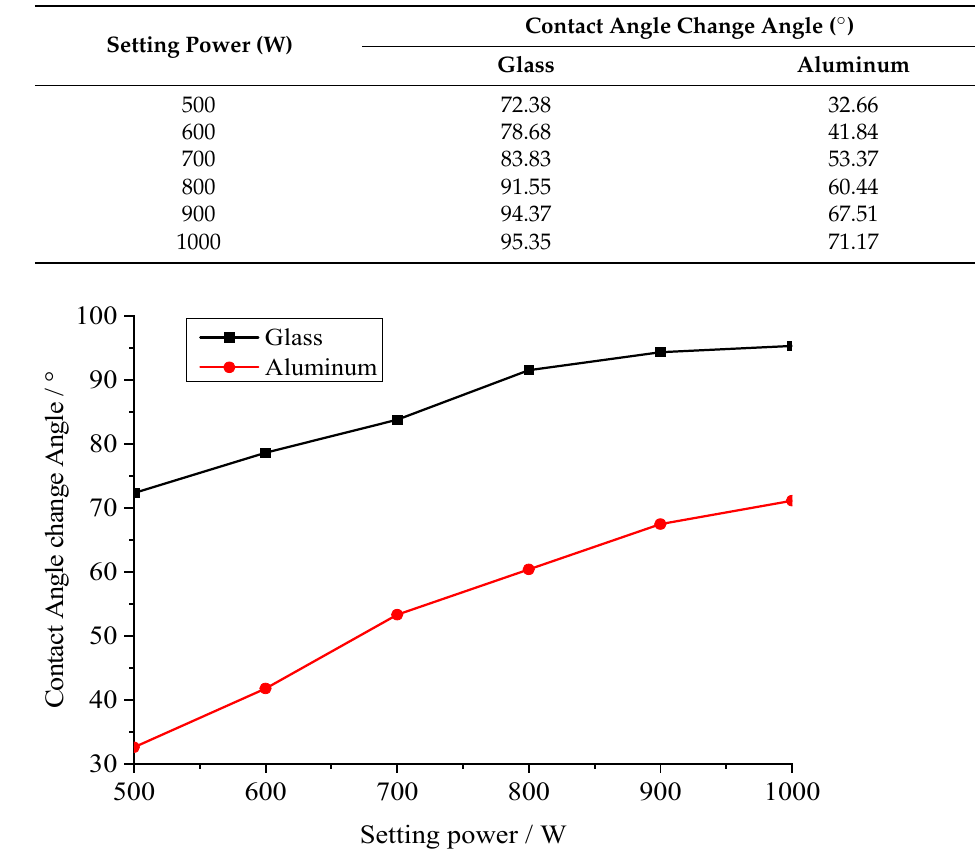
Figure 26. Contact angle curves of glass and aluminum.